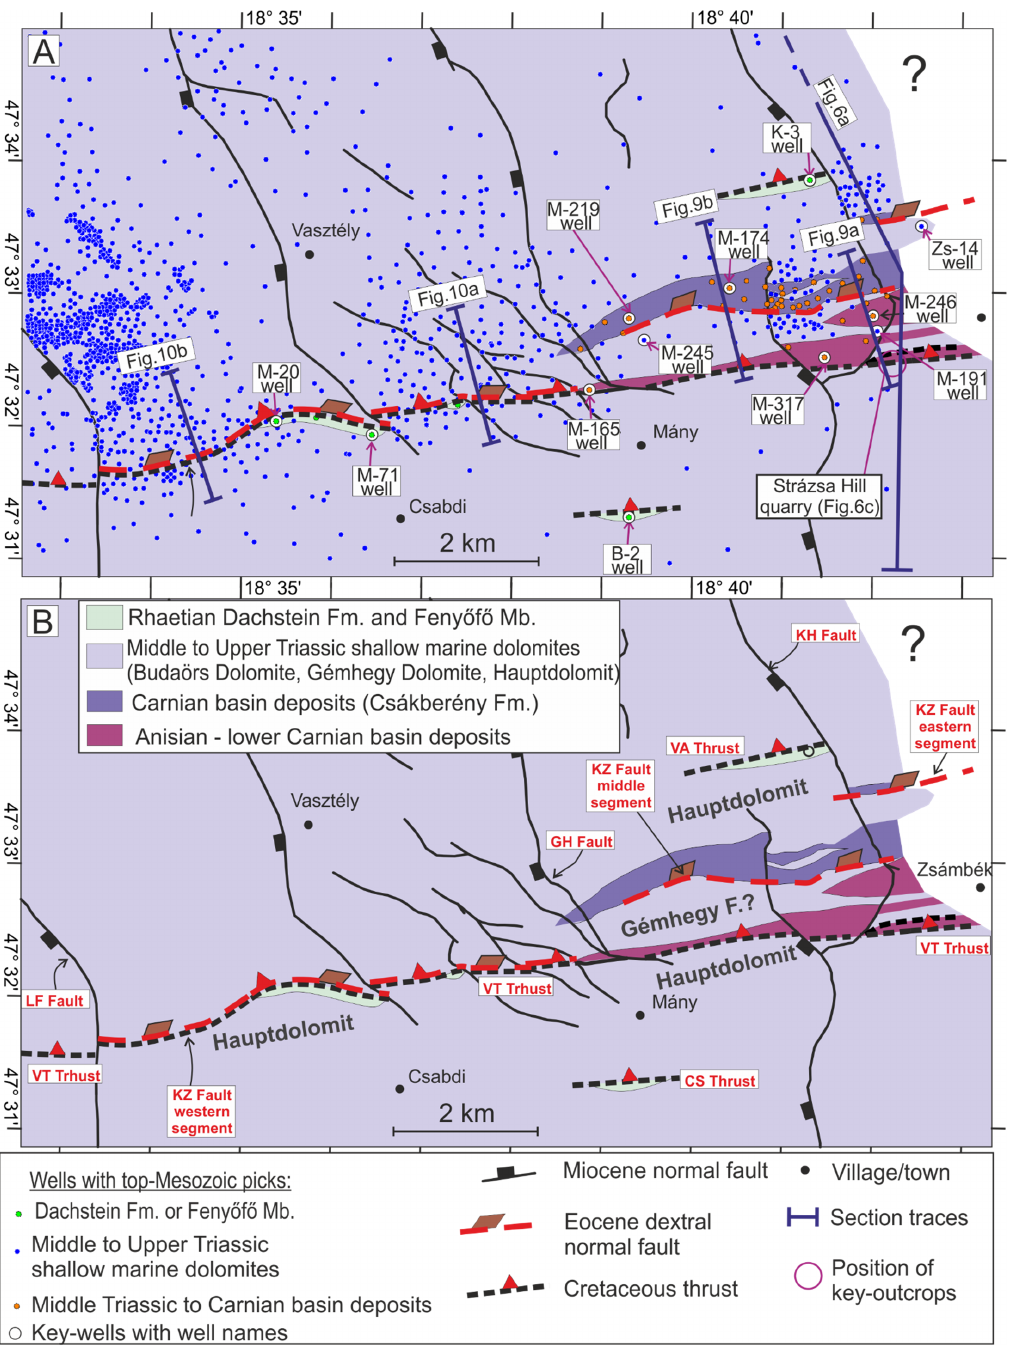
Figure 7. Pre-Cenozoic geological map of the study area (for the location of the map within the Zs á mb é k–M á ny Basin, see Figure 4). ( A ) Position of well data and section traces. The well data are filtered for the topmost Mesozoic picks. Note that most of the Middle to Late Triassic platform carbonates underwent fabric destructive dolomitization, which makes the differentiation of these formations very difficult. Therefore we illustrated these dolomites as one unit. ( B ) Position of major faults. The V é rtessoml ó (VT) Thrust and the Környe-Zs á mb é k (KZ) Fault are illustrated by the cut-off line of the faults and the base-Eocene horizon in this figure. Therefore the traces of these faults differ in Figures 7 and 8. Abbreviations of the faults: CS Thrust: Csabdi Thrust; VA Thrust: Vaszt é ly Thrust; GH Fault: G ó r é Hill Fault; KH Fault: Kakukk Hill Fault; LF Fault: L ó fingat ó Hill Fault. The abbreviations “Fig.” refer to figures of this